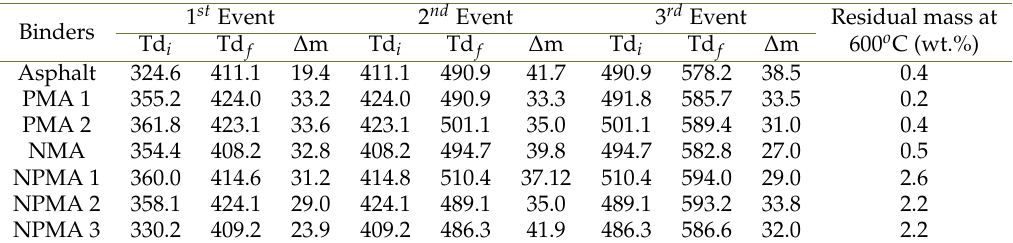
Table 5. TGA results of neat asphalt and modified asphalt binders under air